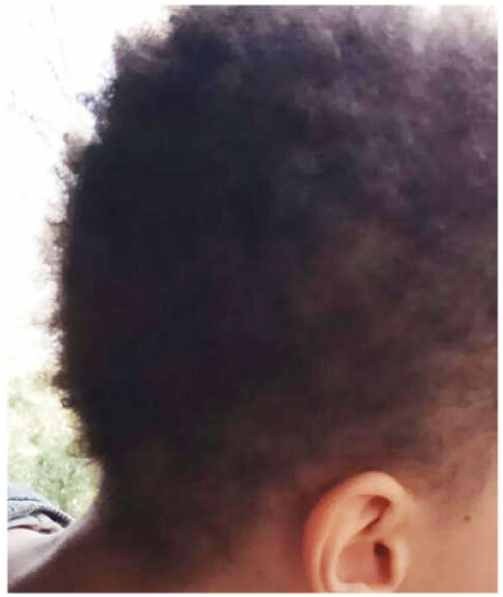
Figure 5. Woolly hair in a 10-y old